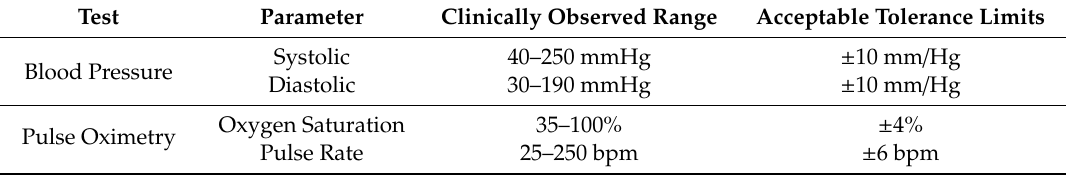
Table 3. Tolerance limits for blood pressure and pulse